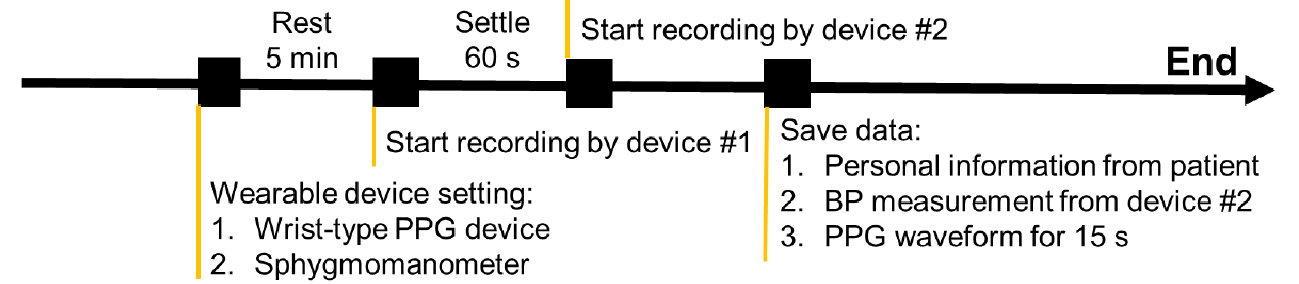
Figure 3. The experimental protocol for the validation of the BP estimation based on wrist-type PPG device. The protocol was designed for static state validation. Note that the resting for 5 min should be conducted at the beginning of the experimental protocol to reduce the interference of the environment and physiological variation. The protocol was consisting of the 5 min rest state and 60-s settle state for simultaneously recording with wrist-type PPG device and sphygmomanometer.